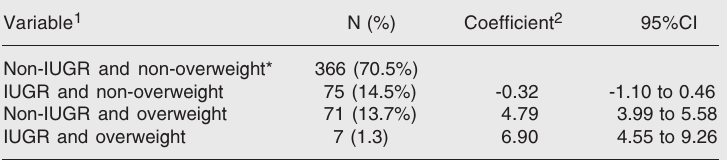
Table 4. Interaction between intrauterine growth restriction (IUGR) and overweight at primary school age on conscript body mass index (BMI) in the multiple linear regres- sion